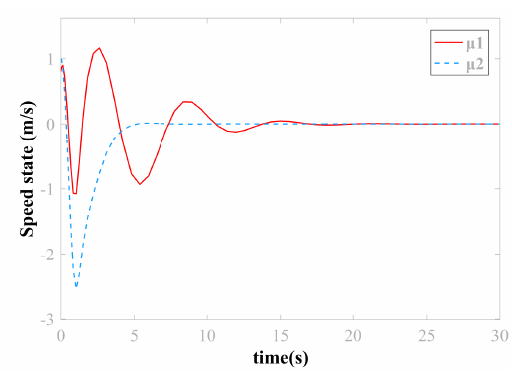
Figure 5. Sway speed state of two ships ( µ 1, µ 2 ) .